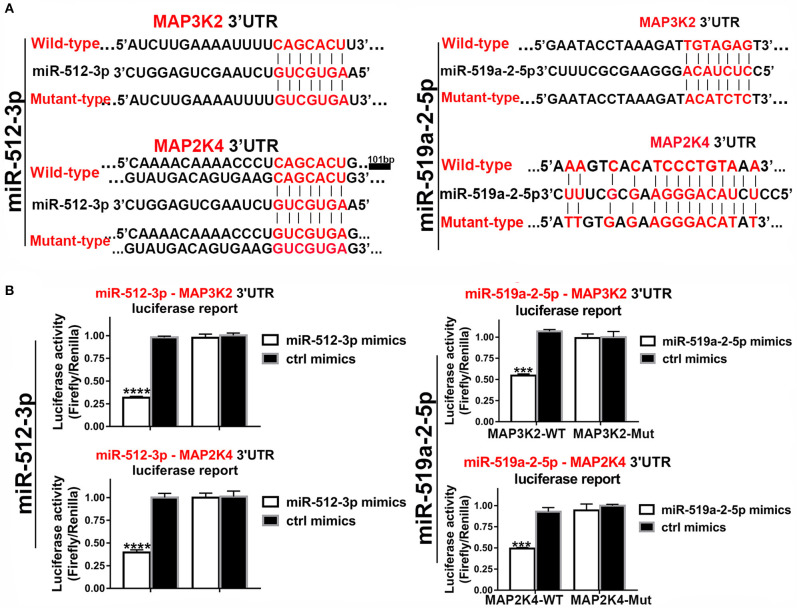
Luciferase assays confirmed the 3, UTR sites of MAP3K2 and MAP2K4 targeted by miR-512-3p and miR-519a-2-5p. (A) The predicted binding site sequence in the 3′UTR of MAP3K2 and MAP2K4 and the Corresponding mutated site. (B) Dual-luciferase assays showed the relative luciferase activities (Firefly/Renilla) among the HEK-293T cells co-transfected with miR-512-3p (left), miR-519a-2-5p (right) or control mimics and luciferase wild-type or mutant reporters. The statistics analysis was performed with the one-way ANOVA test. “***” and “****” represented the p-value < 0.001 and 0.0001, respectively.